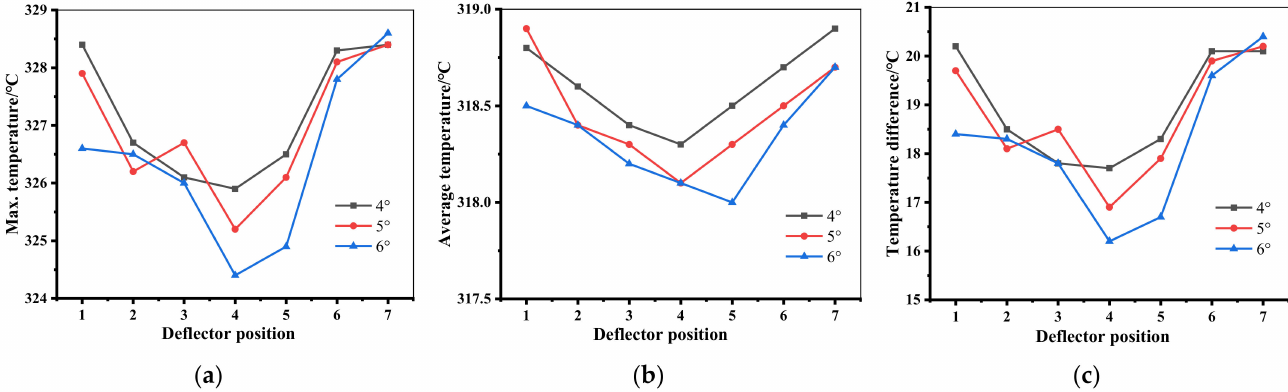
Figure 15. Temperature change curves for the battery pack: ( a ) the maximum temperature change curve; ( b ) the average temperature change curve; and ( c ) the temperature difference change curve.